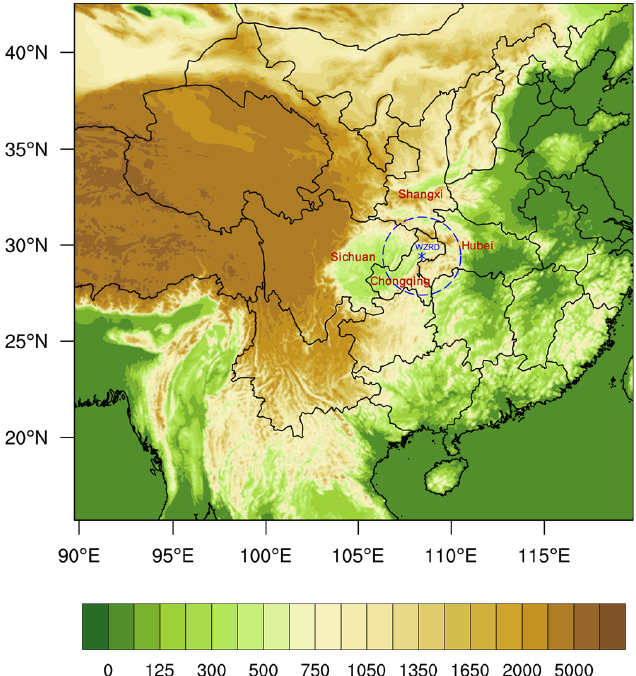
Figure 2. The WRF model domain with the altitude (shade, unit: m) also indicated is the WanZhou radar locations (blue asterisks) and its maximum range coverage circles (blue dotted line). Table 1. Experiment scheme.